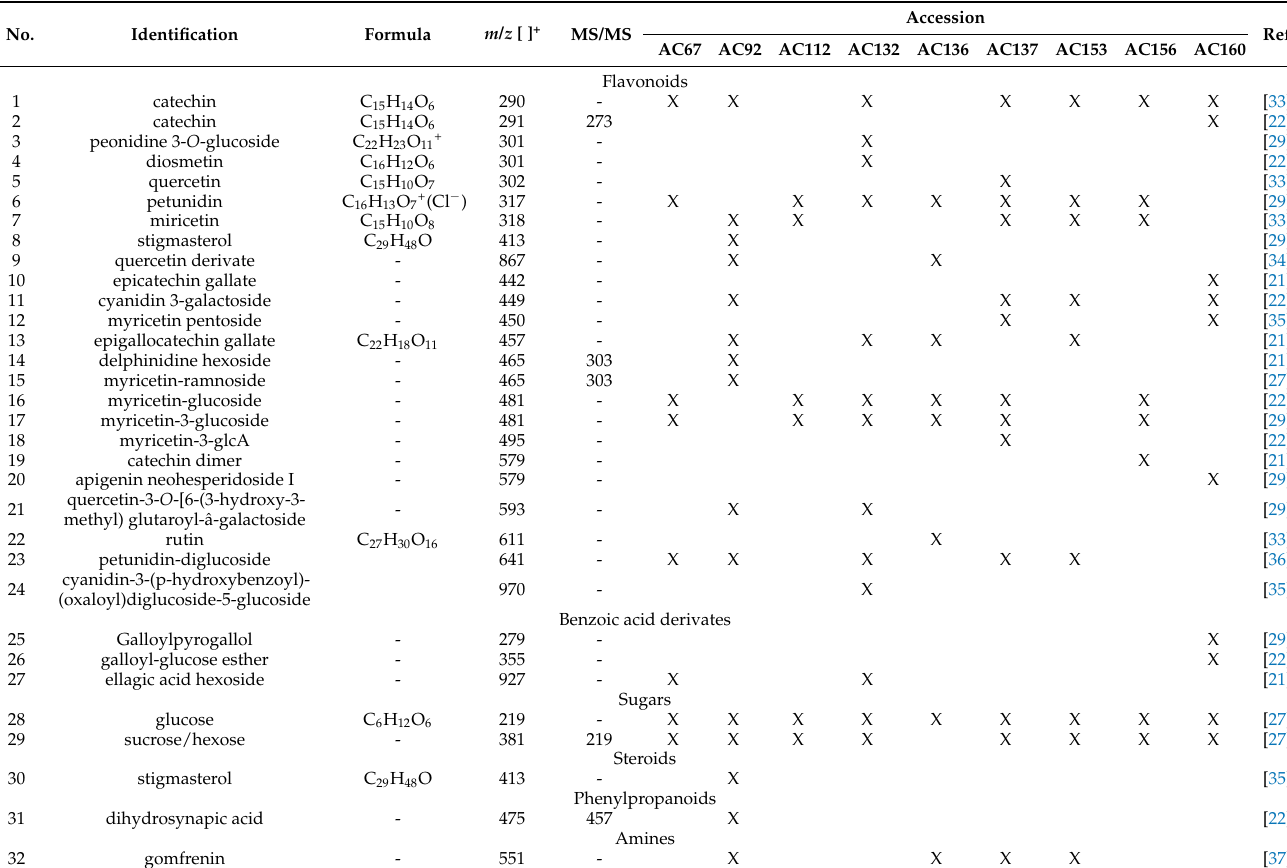
Table 5. Chemical profile of Myrciaria floribunda fruits identified by PSMS on positive ionization